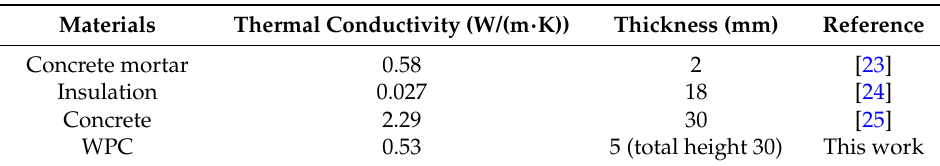
Figure 5. Small-scale models with as-manufactured WPC. ( a ) Without PCM; ( b ) Containing RT 44 in the hollows; and ( c ) With RT 25 in the hollows.